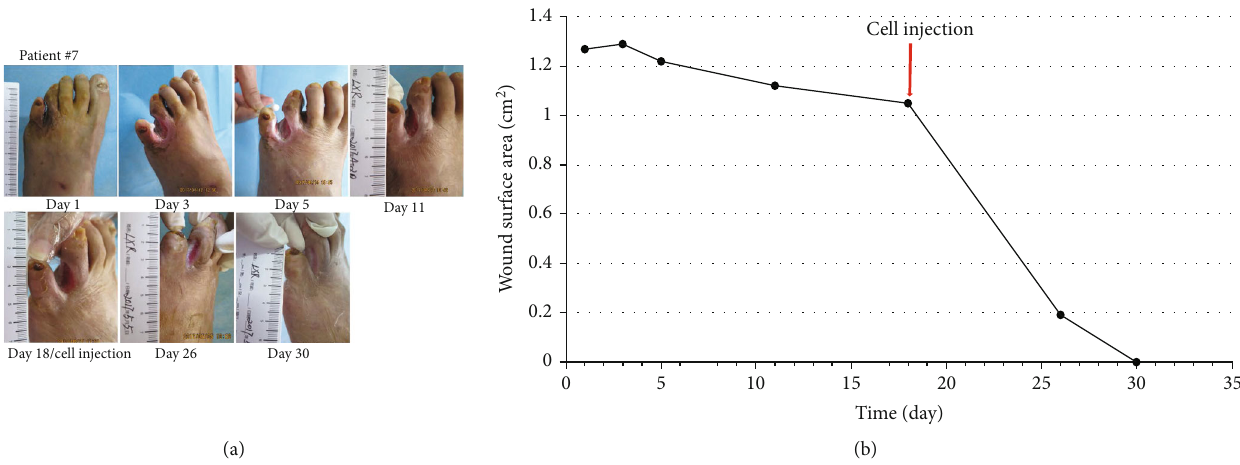
Figure 2: Photographs of ulcer before and after treatment (a) with depiction of wound surface area (b). Patient #7, a 64-year-old woman with a 5-year history of type 2 diabetes, presented with ulcer and infection on her left foot (Wagner 3) for 2 months.